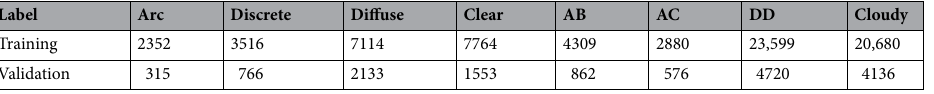
Table 1. Number of images per class used for training and validation of the model. Training and validation do not include images obtained on the same